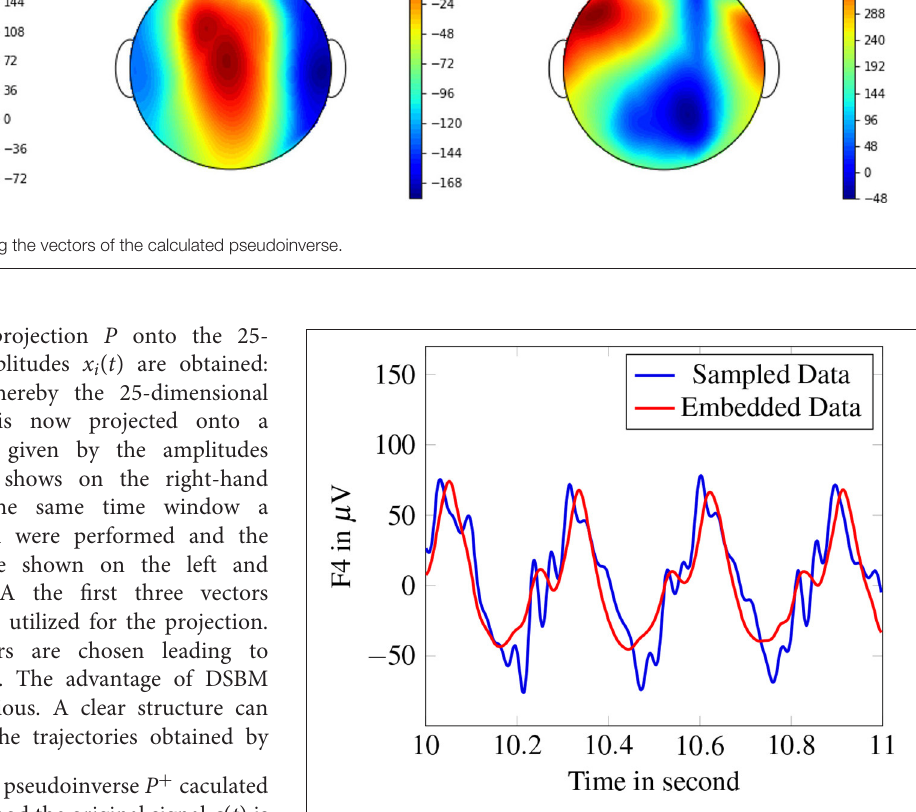
FIGURE 6 | Original signal of F4-electrode compared to reconstructed signal after embedding with the